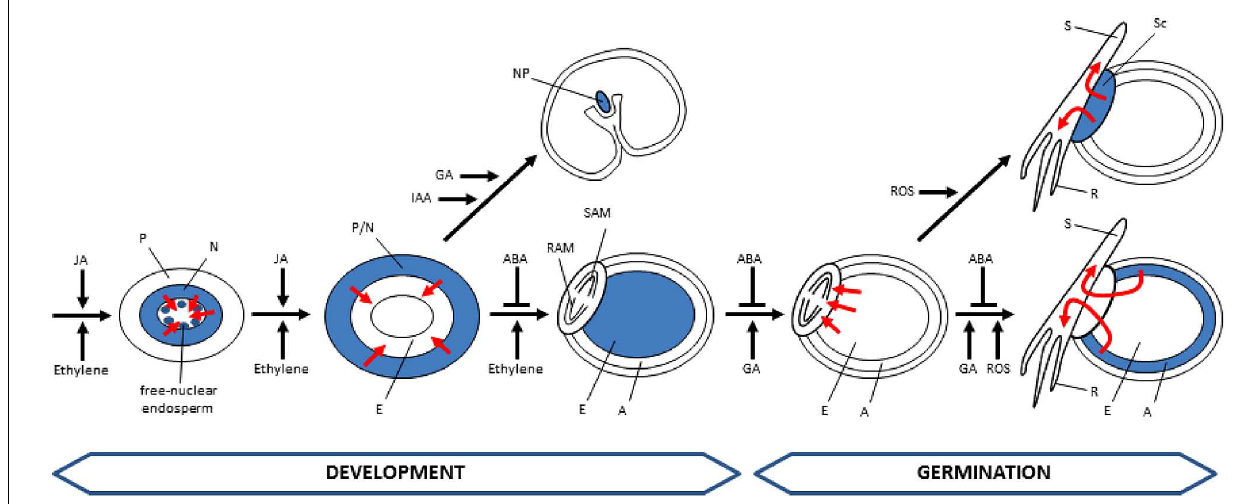
FIGURE 4 | Hormonal control of PCD in developing and germinating cereal seeds. Tissues undergoing PCD are represented in blue. Fluxes of nutrients promoted by PCD events are indicated by red arrows. Cells of the starchy endosperm undergo PCD during development but remain intact until